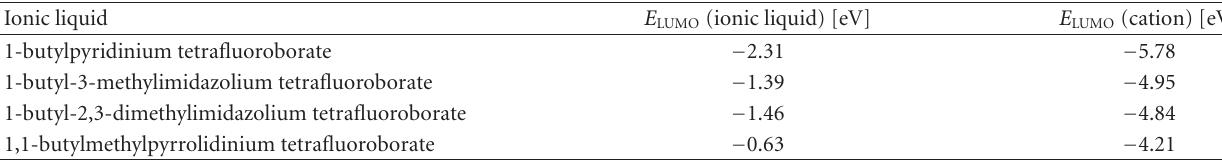
Table 1: E LUMO of several ionic liquids and E LUMO of the cations only (calculated at PM3 level).